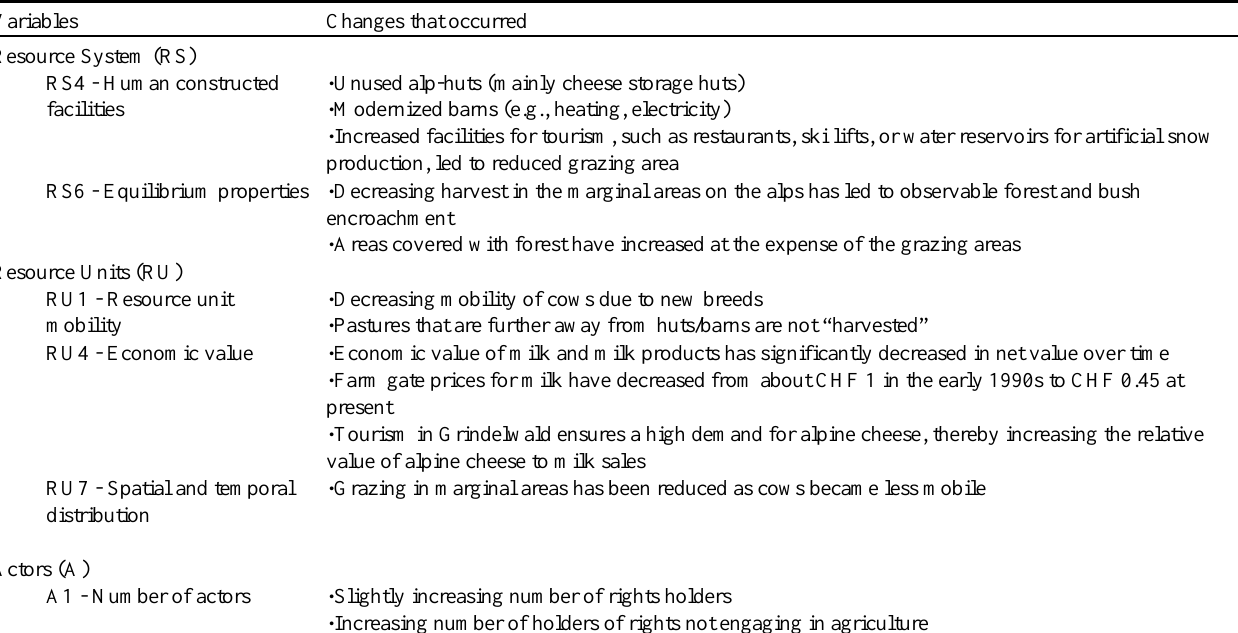
Table 3 . Variables of the social-ecological system framework affected by external socioeconomic developments (industrialization, rapid nonagricultural economic growth, subsidy scheme in agriculture) for the case of Grindelwald.